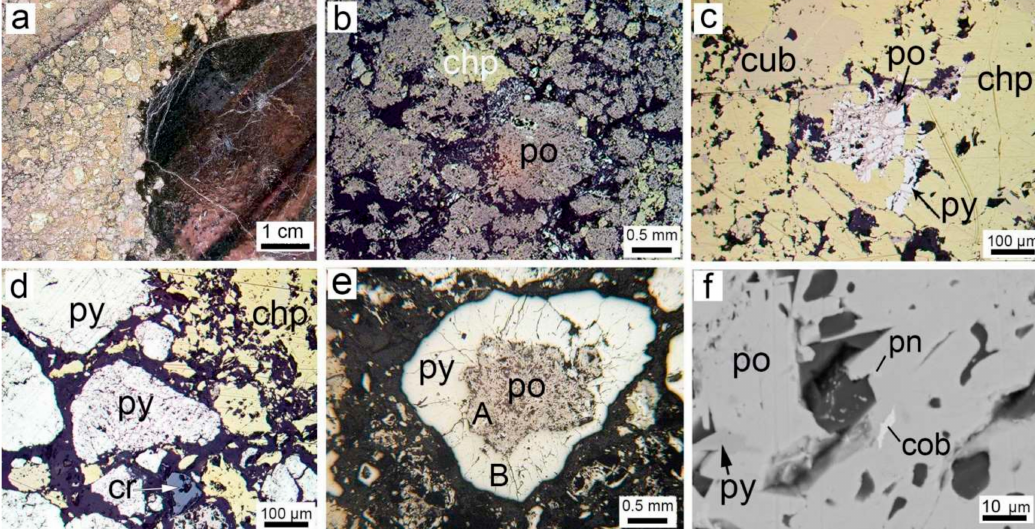
Figure 5. Pyrite nodules in sulfide–serpentinite diagenites of the Dergamysh deposit: ( a ) fragment of sulfide–serpentinitediageniteoftheDergamyshdeposit, drillcoresample; ( b )pseudomorphicpyrrhotite (po) and chalcopyrite (chp) after former pyrite (small white areas inside pyrrhotite); ( c ) replacement of pyrite (py) by pyrrhotite and further by cubanite (cub)–chalcopyrite aggregates; ( d ) clastic textural pattern made up by angular pyrite and chromite (cr) sealed by interstitial chalcopyrite; former pyrite clast with cut textural pattern (from the bottom) is completely replaced by pyrrhotite and later crystalline pyrite; ( e ) zoned pyrrhotite–pyrite nodule with an open-latticework pyrrhotite aggregate in the core (zone A—former fine-crystalline or fine-grained pyrite) and a rim of coarse-crystalline pyrite (zone B); ( f ) cobaltite (cob), pentlandite (pn), and pyrite inclusions in pseudomorphic pyrrhotite. Reflected light ( b – e ), SEM image ( f